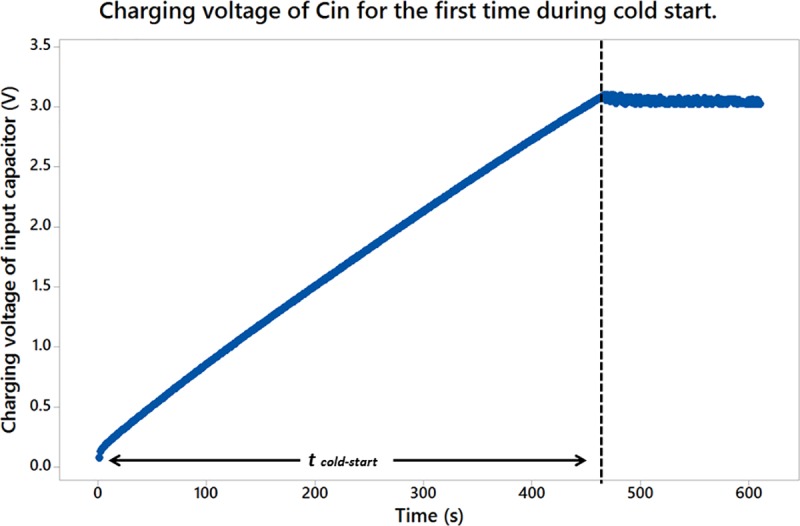
Increment of VCin during the charging of the input capacitor for the first time.